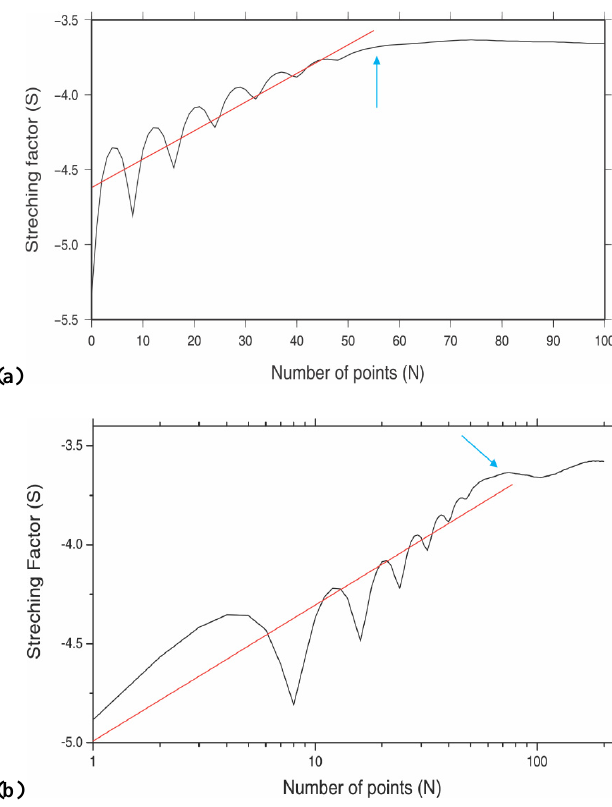
Fig. 7. (a) Example of the estimation of MLE using the method of Rosenstein et al. (1993) for event #5. (b) The same plot as above; only the x axis is logarithmic (see text for more details). The por- tion of the curve used for the least-squares line fit starts from the beginning until the saturation point shown by the blue arrow. The red line represents the resulting least-squares line fit.